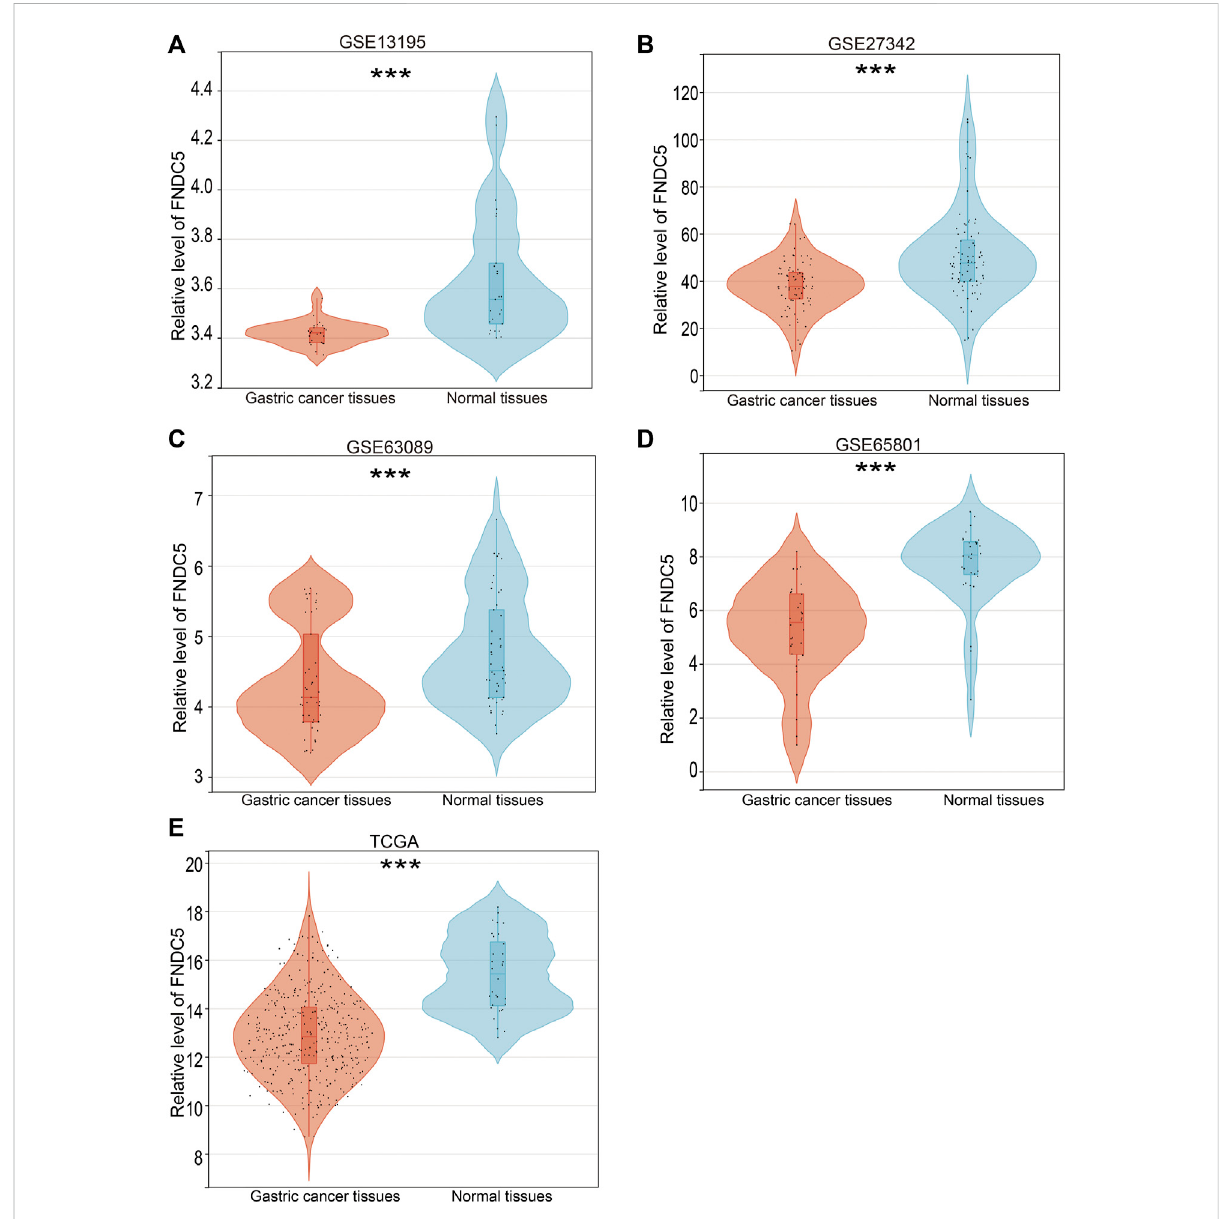
FIGURE 1 FNDC5 expression ingastric cancerbased onGEO and TCGAdatabases. ThemRNA levelsof FNDC5wereanalyzed ingastric cancer tissueand adjacent normal gastric tissue based on (A) GSE13195, (B) GSE27342, (C) GSE63069, (D) GSE65801, and (E) TCGA. ***, p <